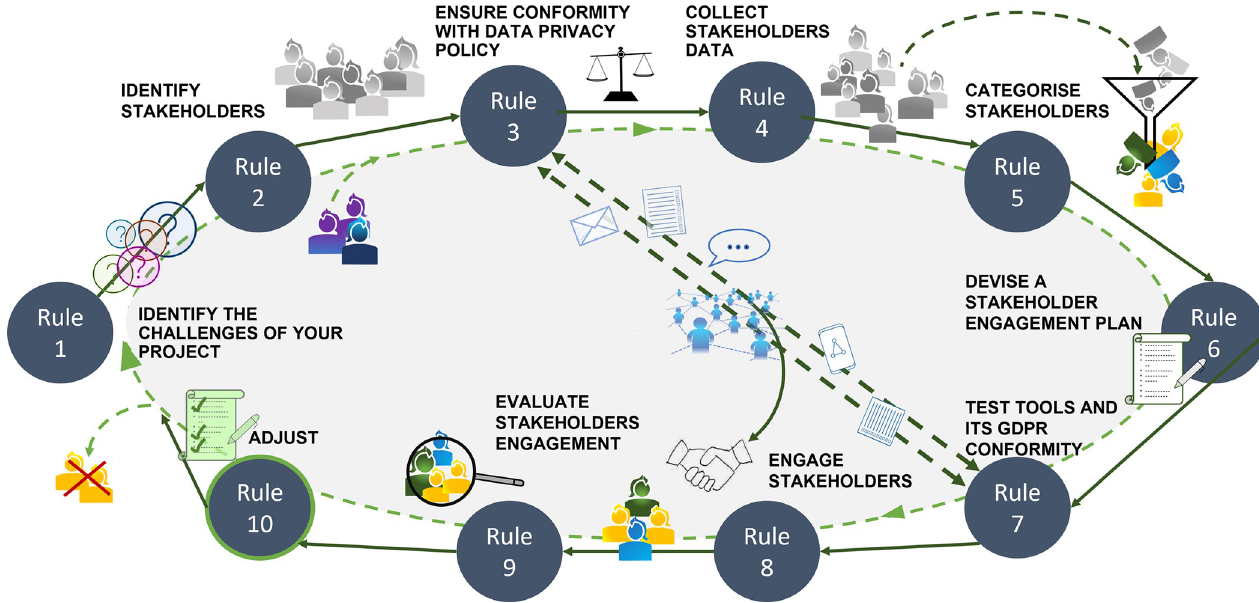
Fig 3. Ten simple rules to develop a stakeholder engagement plan. Workflow. The scheme demonstrates an optimal workflow for the generation of a stakeholder engagement plan including the preparatory, implementation, and follow-up phase for a complete cycle.